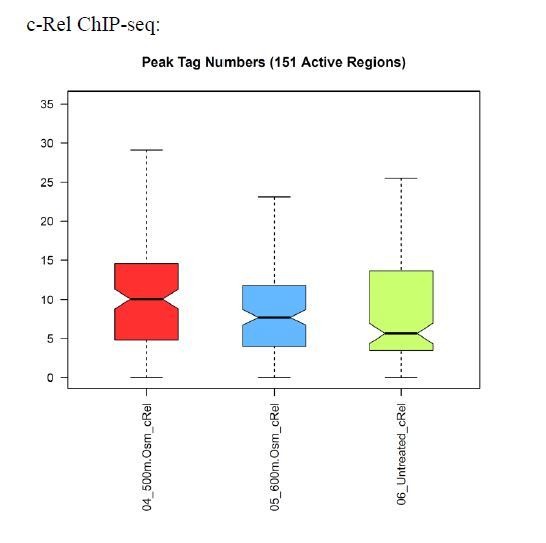
Number of ChIP-seq peaks for regions actively binding c-Rel were low, indicating failure of experiment.